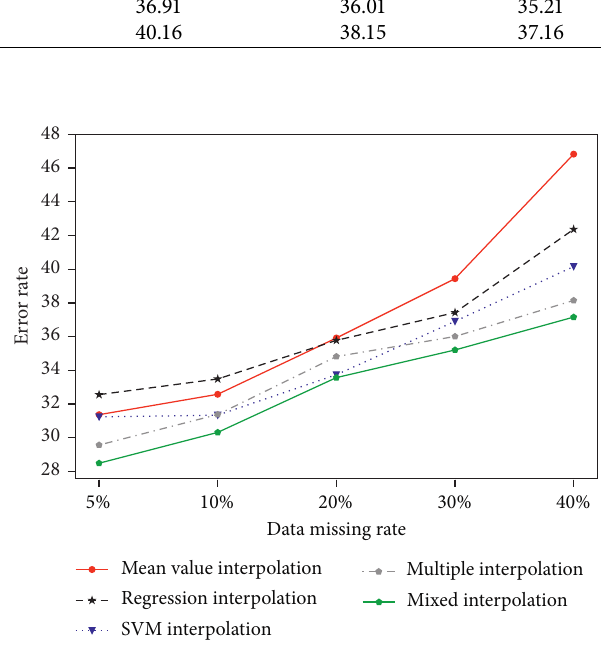
Figure 10: Error rate of five interpolation methods under different data missing